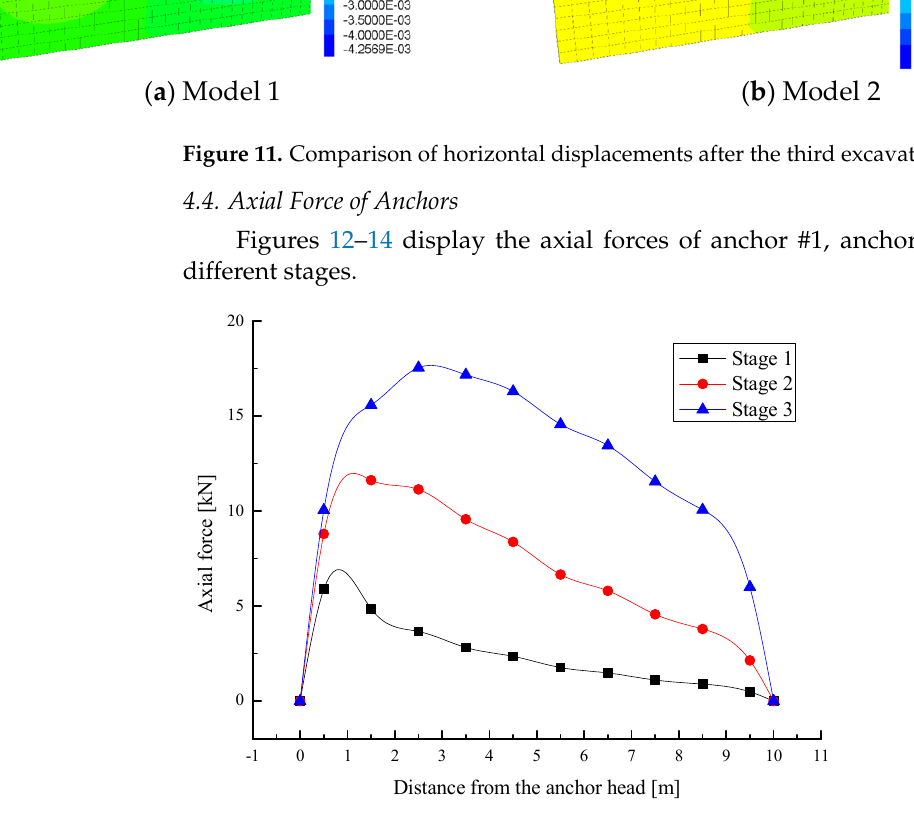
Figure 12. Axial forces of anchor #1 at different stages.